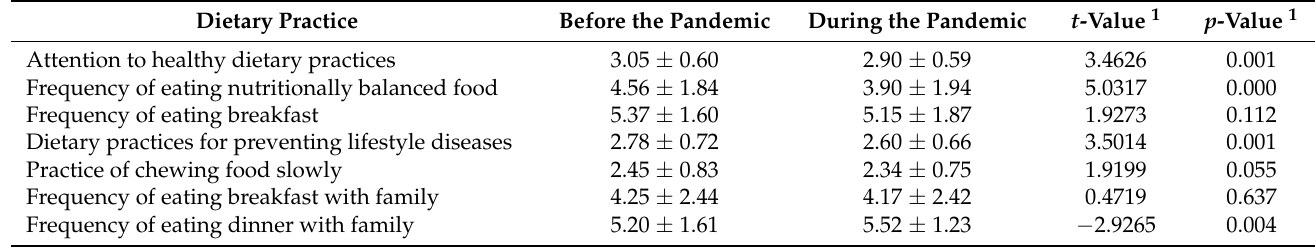
Table 2. Mean scores of dietary practices before and during the COVID-19 pandemic.